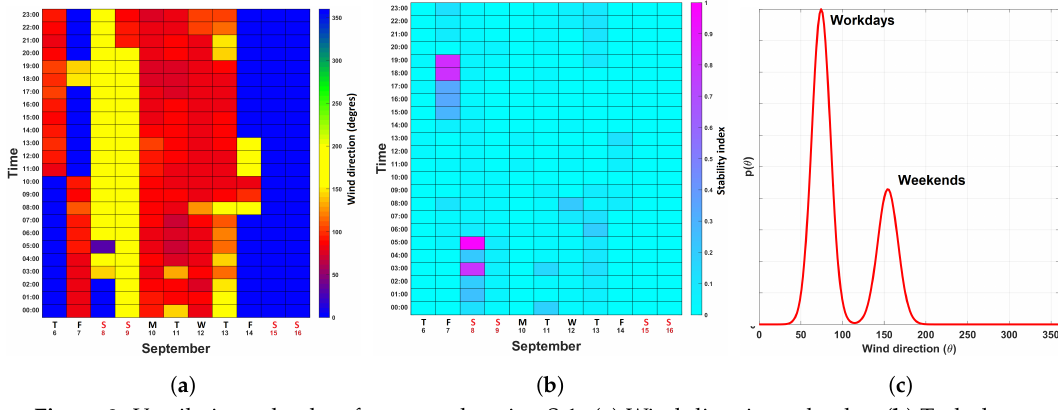
Figure 8. Ventilation calendars for sensor location S-1. ( a ) Wind direction calendar. ( b ) Turbulence calendar. ( c ) mvM ( θ ) computed from data collected from September 6th to September 16th.